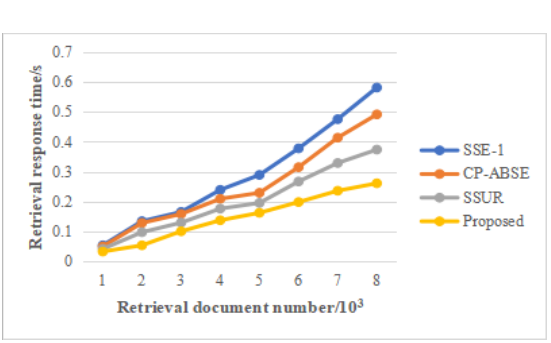
Figure 10. Comparison of retrieval efficiency between two distributed multi-keyword retrieval